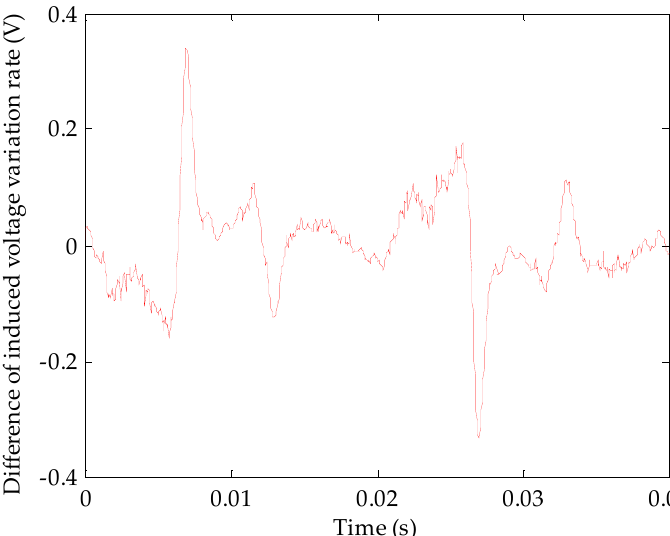
Figure 14. Difference in the induced voltage change rates for both detection coils with rated load when the dynamic eccentricity was 1% and a 1-turn short circuit occurred.